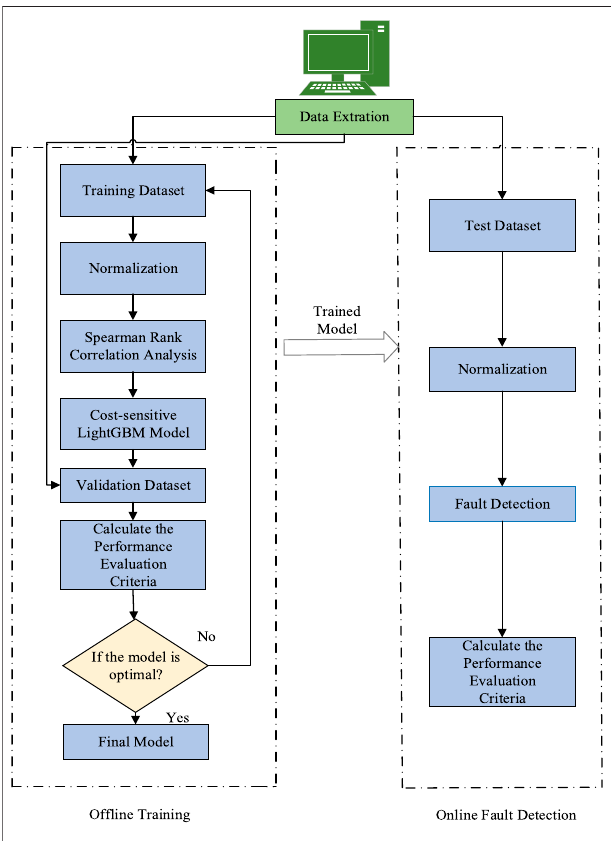
FIGURE 3 | Wind turbine fault detection procedure of cost-sensitive LightGBM